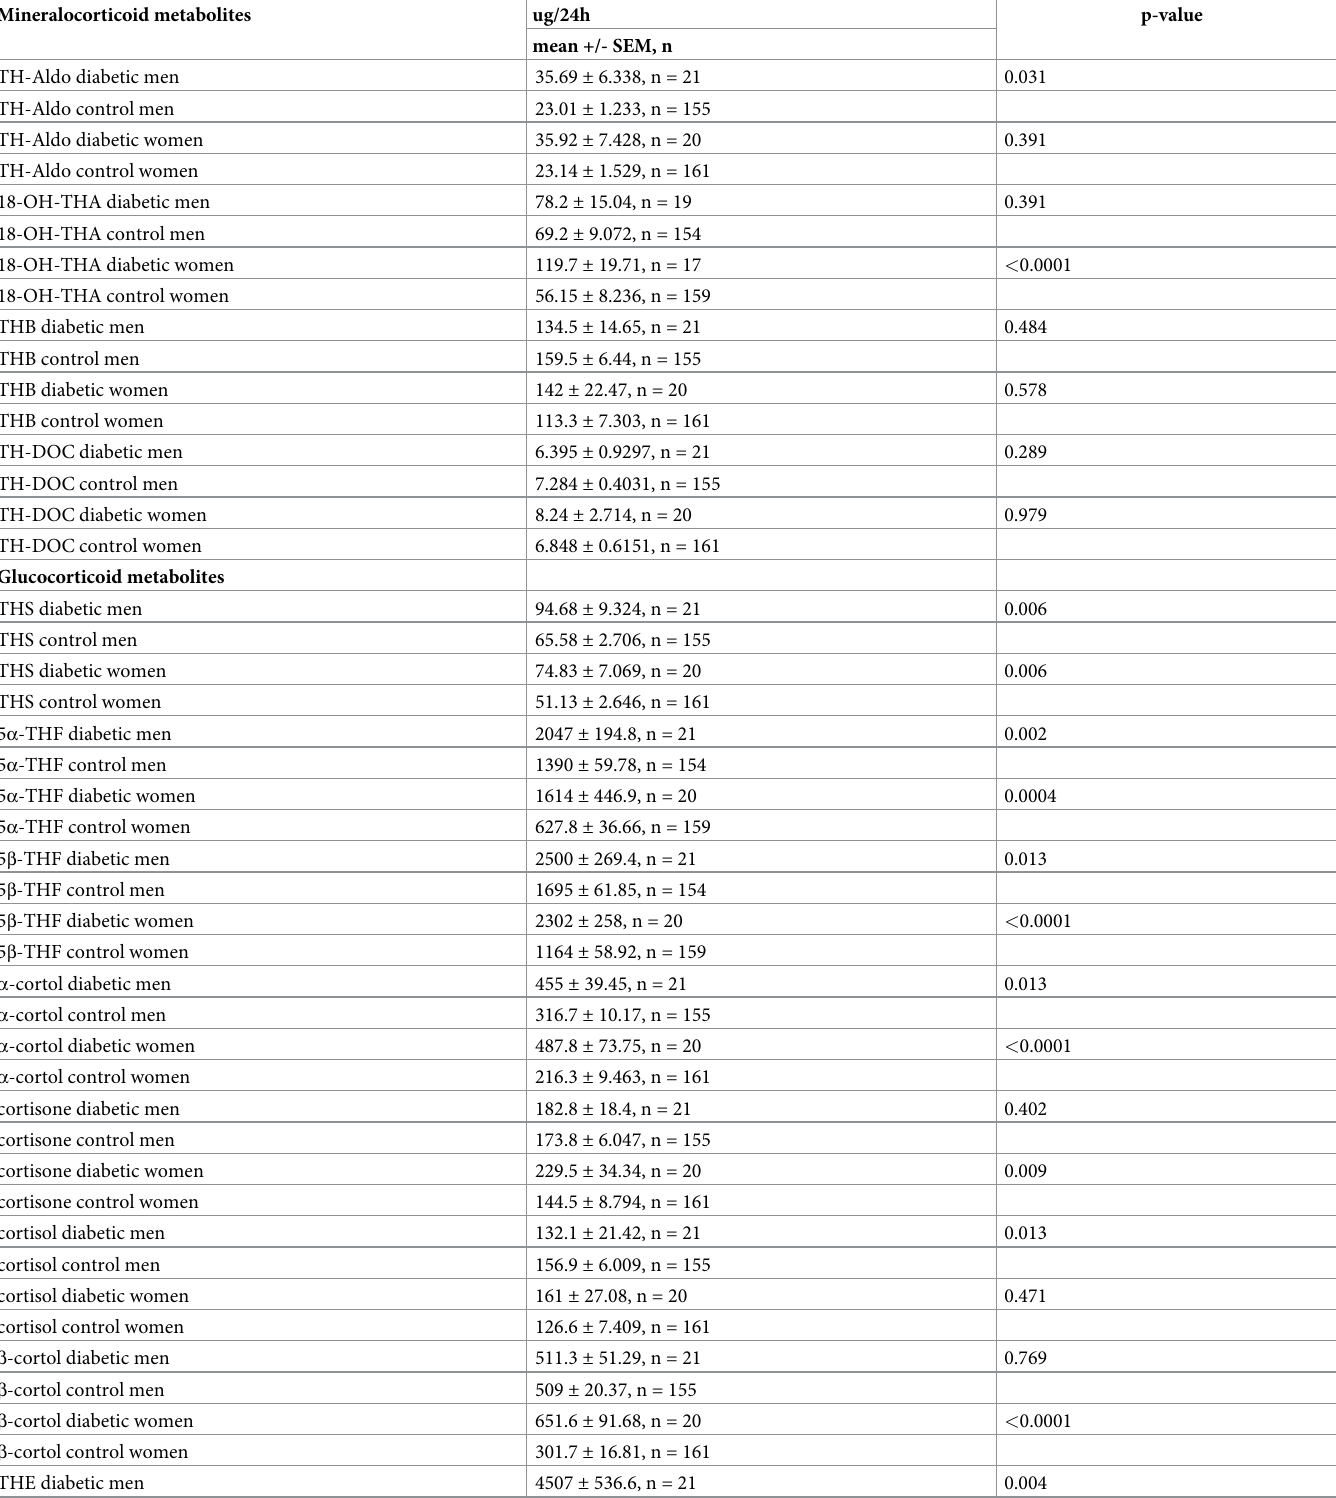
Table 2. Absolute values of the urinary steroid hormone metabolites of the two human cohorts. Mineralocorticoid